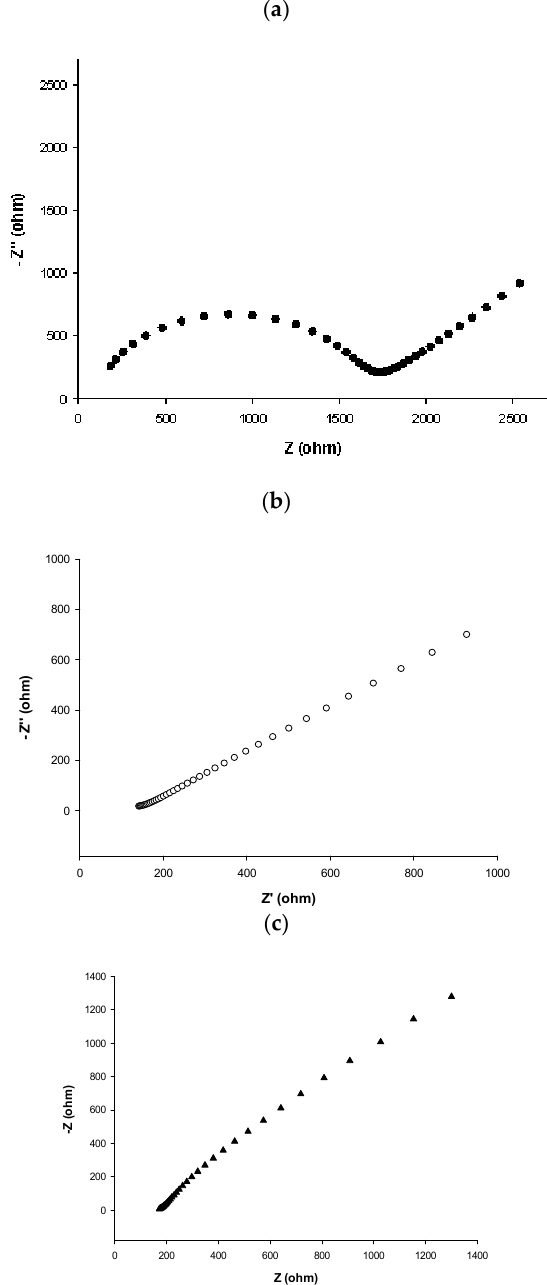
Figure 5. The Nyquist plots of Au bare ( a ), Au/SWCNT ( b ) and h-nPG ( c ) electrodes in 0.1 M KCl containing 5.0 mM Fe(CN) 63 − /4 − .